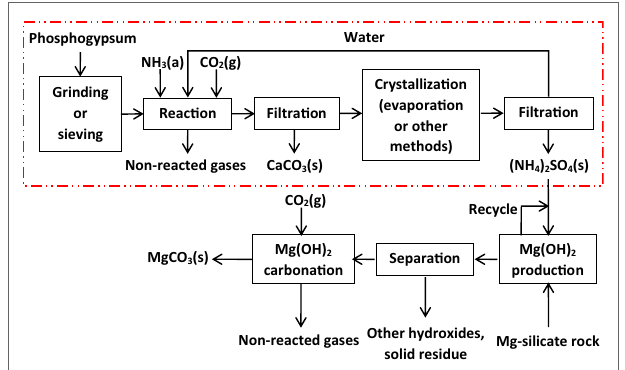
FigUre 1 | Process concept for mineral carbonation of phosphogypsum waste (dashed rectangle) combined to a magnesium silicate rock carbonation concept . The latter part of the schematic drawn according to results by Nduagu